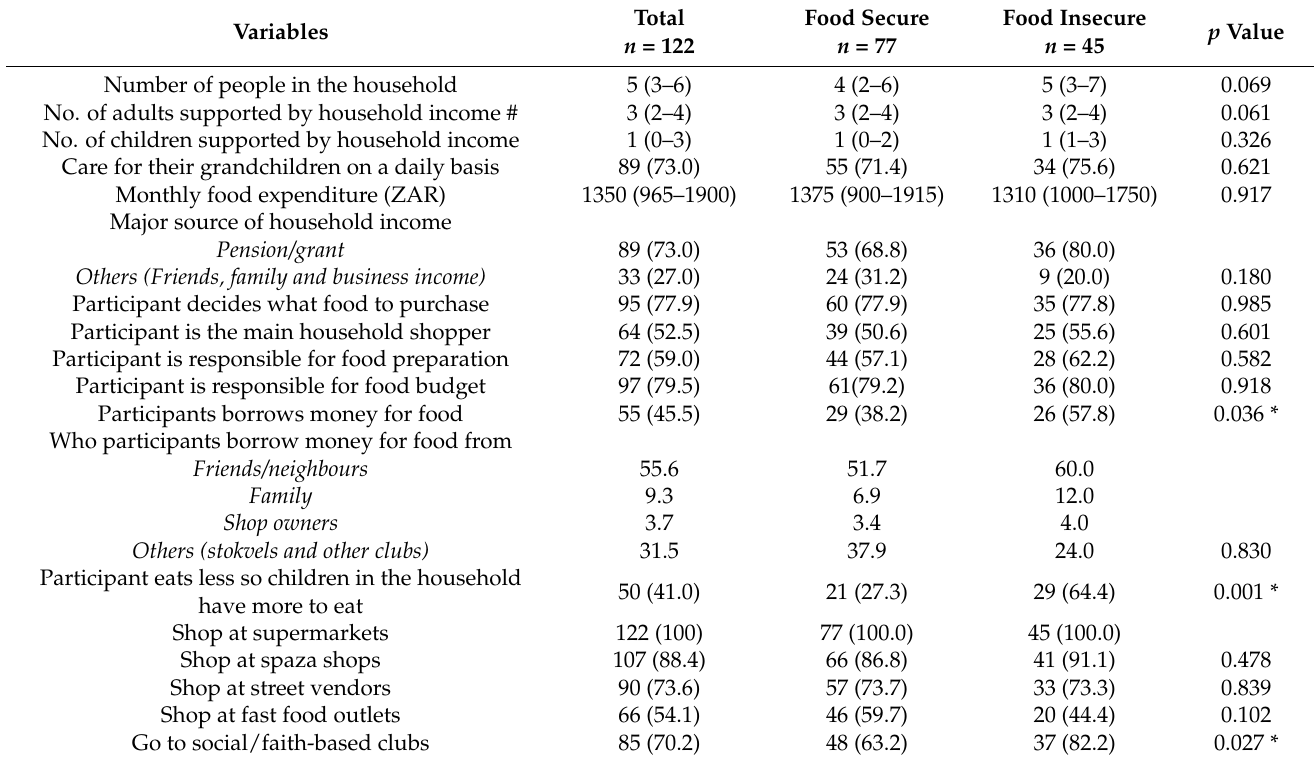
Table 2. Household and food decision characteristics of